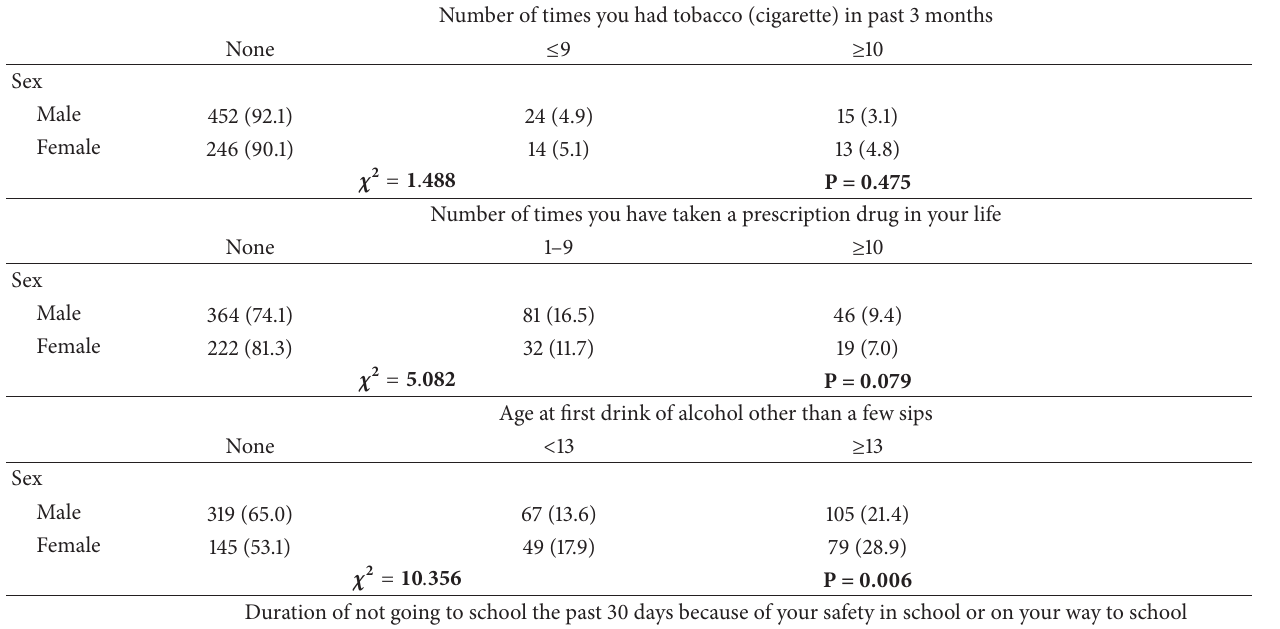
Table 4: Associations of sex with adolescent